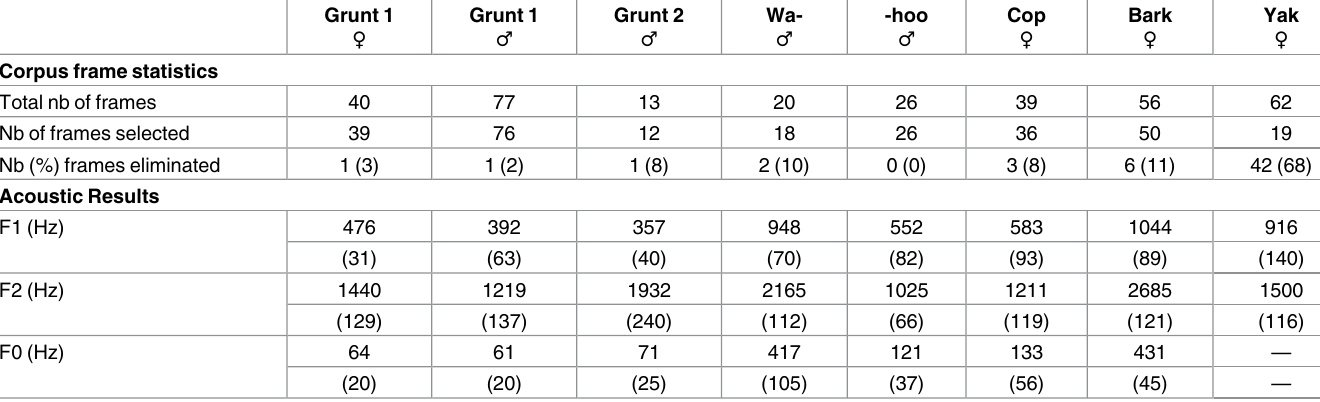
Table 2. Corpus frame statistics and acoustic results.